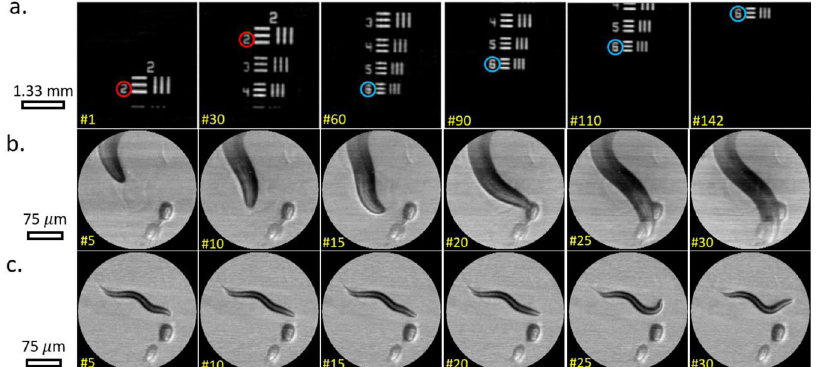
Fig. 4 Video recording of moving objects. a Video capturing of vertically shifted resolution target, 101 × 103 resolution and 72 fps frame rate. Total recording rate of 0.75 M pixels per second. Frames 1, 30, 60, 90, 110, and 142 out of the 142 captured frames are presented. The red and blue circles mark constant positions on the resolution target. b , c Videos capturing the motion of C. elegans worms at a frame rate of 10 fps, corresponding to a total recording rate of 0.7 M pixels per second. Frames 5, 10, 15, 20, 25, and 30 out of 31 frames are